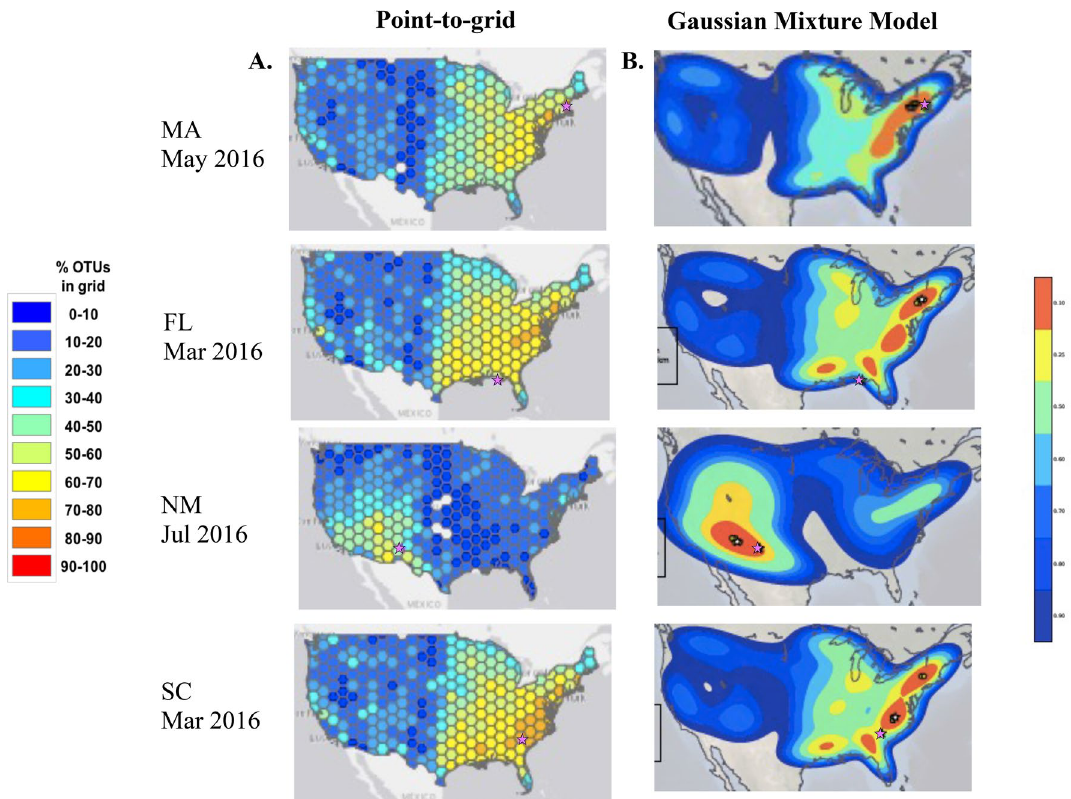
Figure 4. ( A ) Point-to-grid maps displaying overlaid distributions from OTU using ITS2 and rbcL -3A minibarcodes generated from 14-day dust samples collected from four locations on the dates indicated. Grid color represents the percentage of total OTU in that sample that had a threshold number of point occurrence records within that grid. The location of sample collection is indicated (pink star). ( B ) Maps showing the result of Gaussian modeling model fitting to the data generated in the point-to-grid map. The location of sample collection is indicated (pink star) as are the locations of the top five peaks used to calculate AT5PE. Maps were generated using python packages interacting with ArcGIS v10.4, as described in “Methods”. All samples